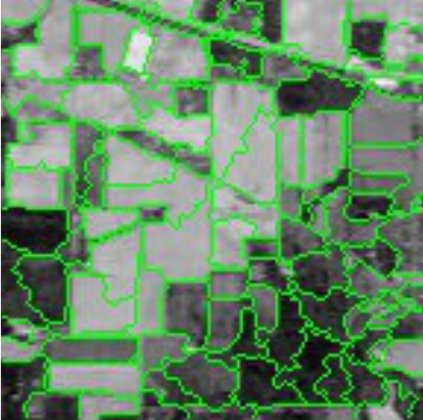
Figure 2. The superpixel segmentation of the Indian Pines dataset.